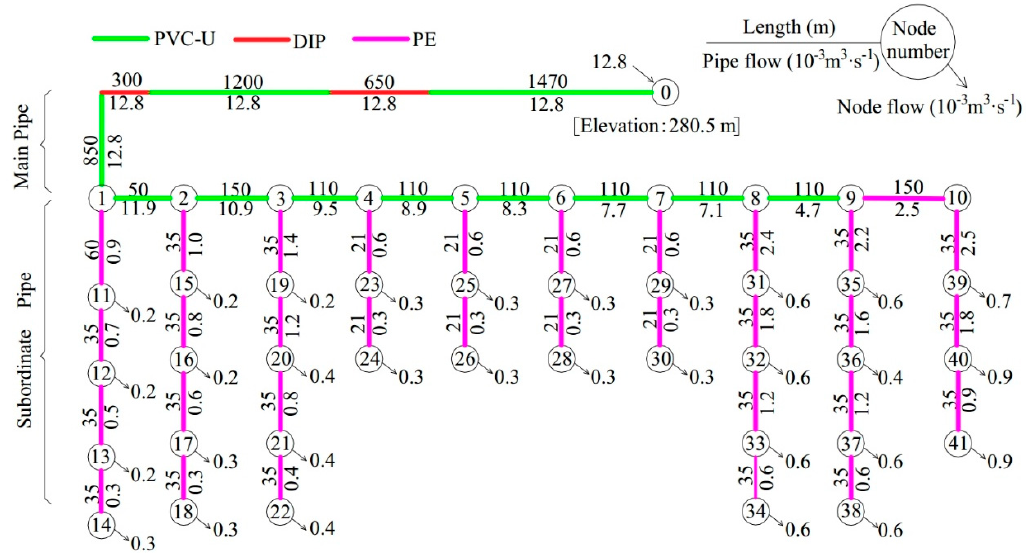
Figure 3. Generalization diagram of pressurized tree-type WDN in Xinjiang Uygur Autonomous Region, China (44°02 ′ –45°23 ′ N, 79°53 ′ –83°53 ′ E). PVC-U: Unplasticized poly (vinyl chloride) pipes; DIP: Ductile iron pipes; PE: Polyethylene pipes.